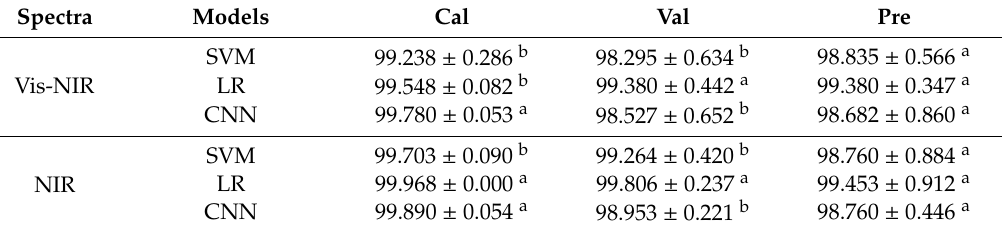
Table 2. The results of the classification models based on PCA score features.